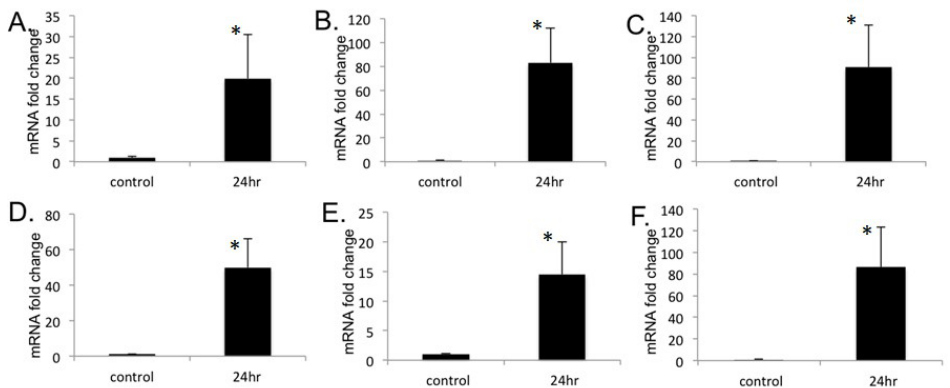
Figure 3. PPARα agonist Wy-14,643 treatment of H9c2 cardiomyoblasts for 24 h induced mRNA expressions of Pde2 , Pde6 , Pde7 , Pde8 , Pde10 , and Pde12 : H9c2 cells were treated with 100 μM Wy-14,643 for 24 h. Total RNA from cells were used for RT-qPCR analysis. ( A ) Pde2 mRNA levels increased by 20-fold. ( B ) Pde6 mRNA levels increased by 83-fold. ( C ) Pde7 mRNA levels increased by 91-fold. ( D ) Pde8 mRNA levels increased by 50-fold. ( E ) Pde10 mRNA levels increased by 14-fold. ( F ) Pde12 mRNA levels increased by 87-fold. GAPDH was used as loading control. Data was analyzed by t -test, n = 4–6 per group; all sample values were compared to control values. * p <